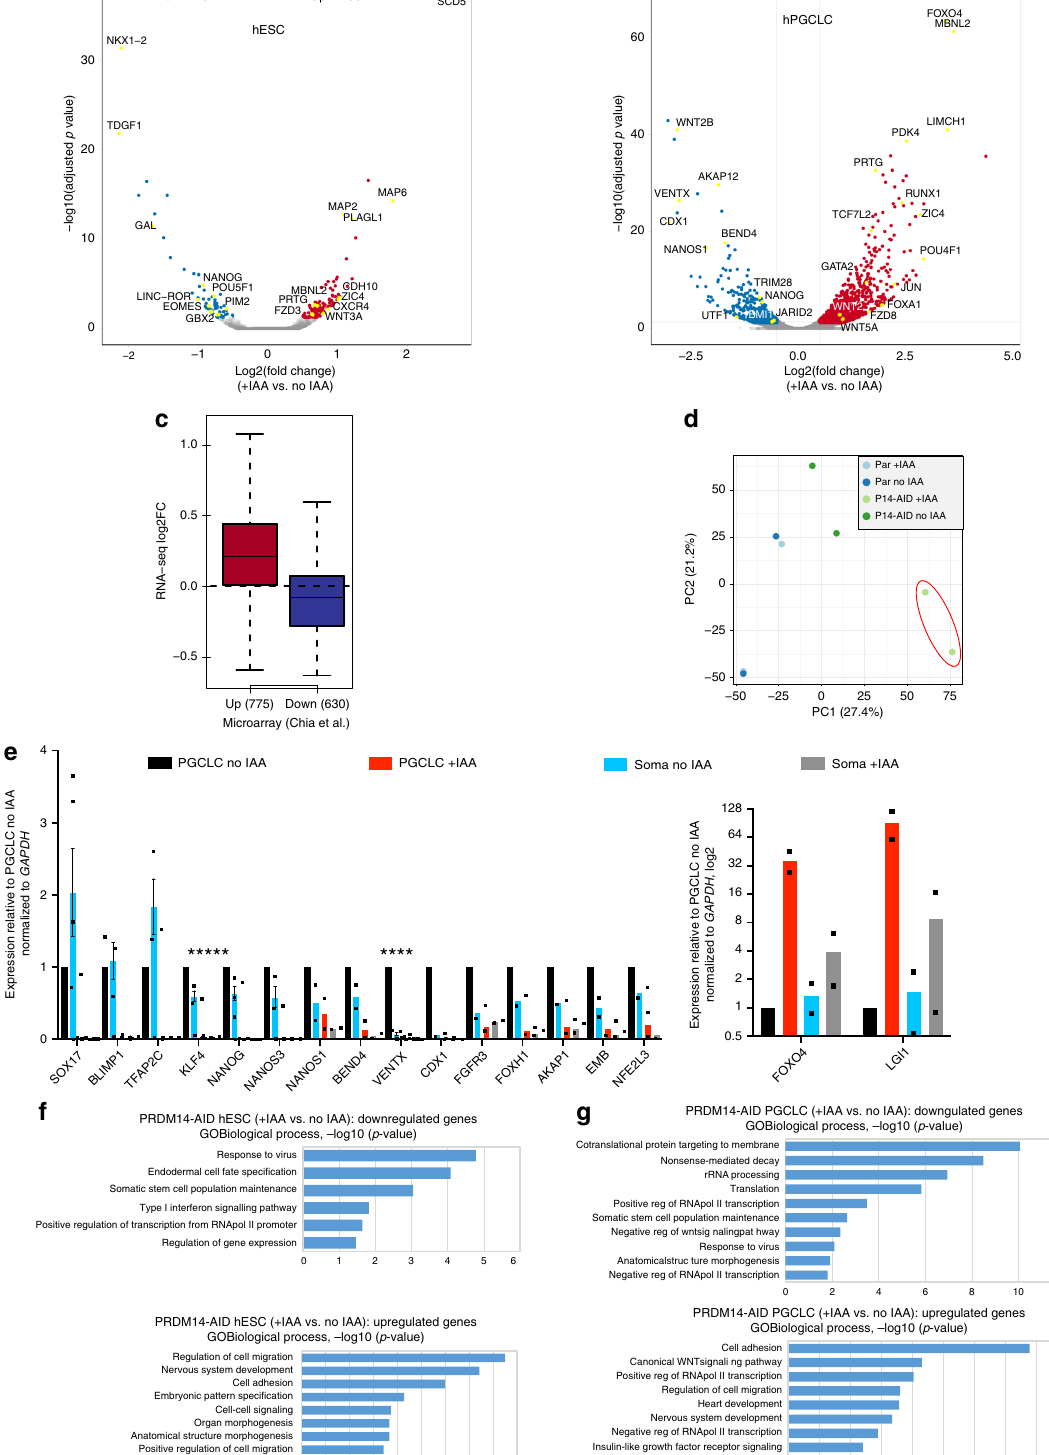
markers, particularly of the neural lineage (e.g. MAP2 , MAP6 and SOX2 ) (Fig. 6a, Supplementary Fig. 6E and Supplementary Data 1). Gene ontology (GO) analysis re fl ected reduction in self-renewal (enriched downregulated term “ somatic stem cell maintenance ” ) and upregulation of pro-differentiation genes